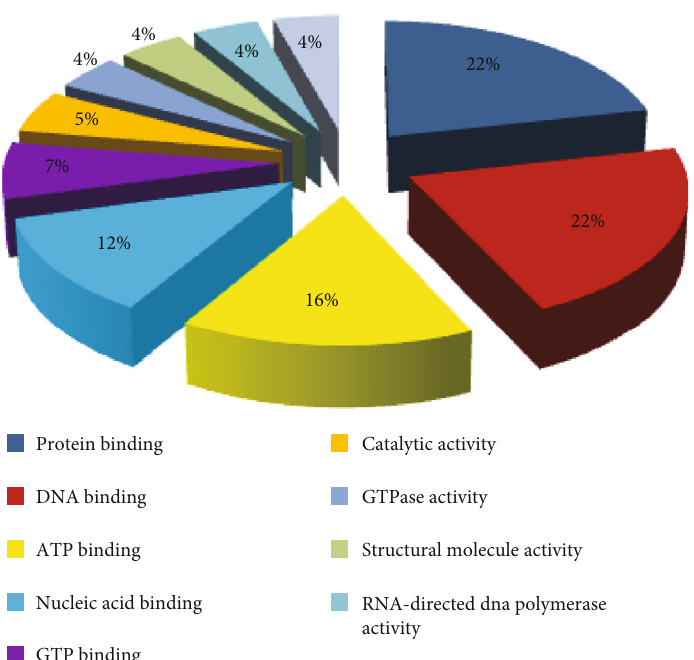
Figure 6: Gene Ontology (GO) distributions for reniform nematode genomic sequences as determined by Blast2GO and grouped by molecular function for the REPLI-g library.